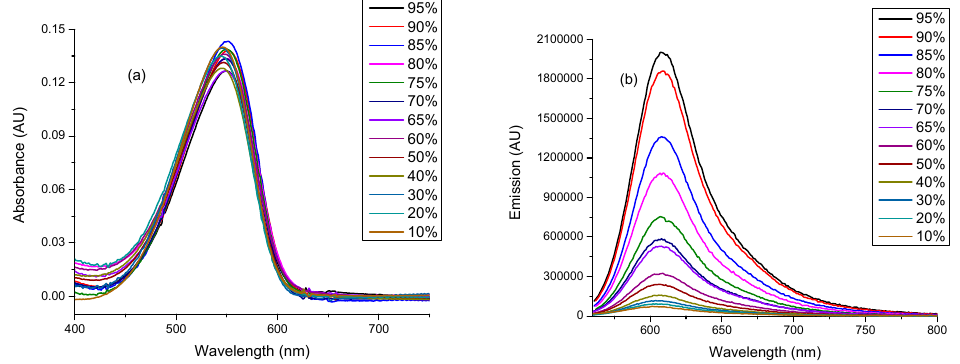
Figure 2. Absorption ( a ) and emission ( b ) spectra of dU-BZ obtained as a function of viscosity in glycerol/methanol ( v / v ) solutions; percentage indicated is the glycerol content of the solution.